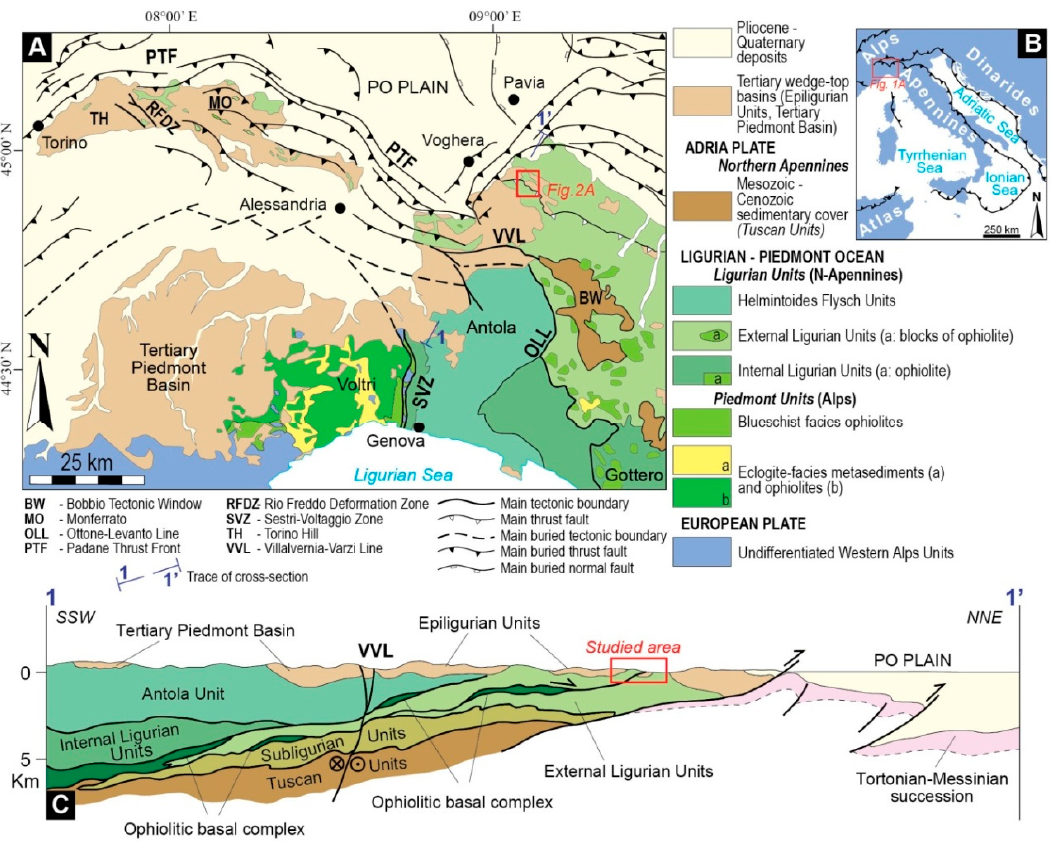
Figure 1. Structural sketch map ( A ) of the northwestern Italy (modified from [88] and [73]); ( B ) location of Figure 1A; ( C ) geological cross section across the Northern Apennines (modified from [89]).